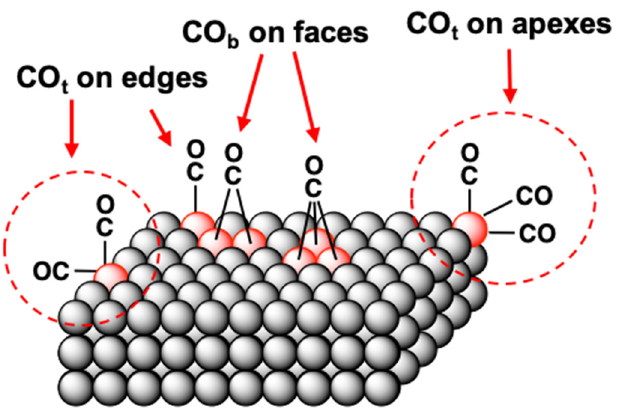
Figure 6. Coordination modes of CO to a metal surface. Adapted from reference 28. Copyright 2018 American Chemical Society.